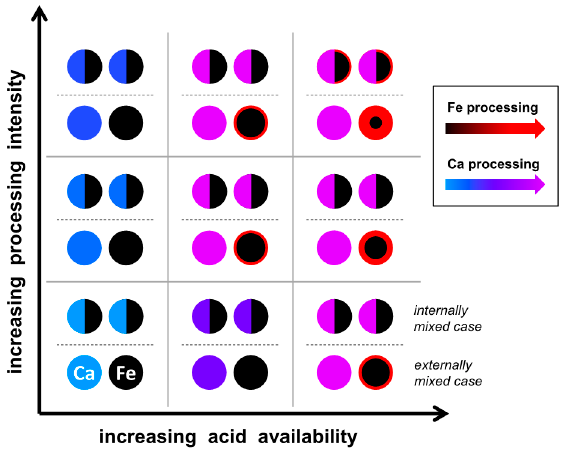
Figure 5. Conceptual model of atmospheric acid processing for dust particles mixed internally or externally with respect to calcium and iron compounds. Atmosphere 2020 , 11 , x FOR PEER REVIEW